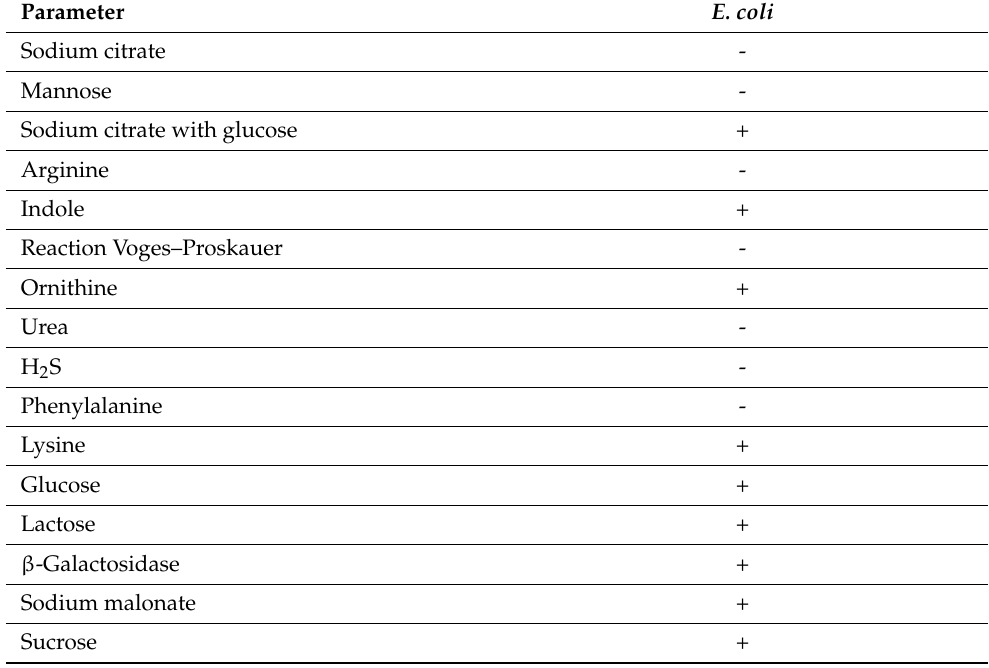
Table 2. Results of the biochemical test of E. coli